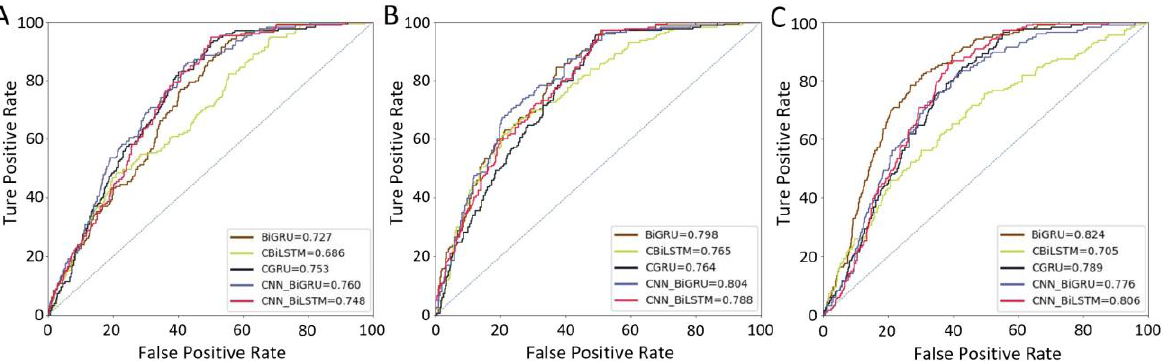
Figure 4. The ROC curve in the neoplasm T staging and grading of different deep learning prediction models. ( A ) The ROC curve in neoplasm T staging of different deep learning prediction models. ( B ) The ROC curve based on the 1973 WHO grading classification of different deep learning prediction models. ( C ) The ROC curve based on the 2004 WHO grading classification of different deep learning prediction models.